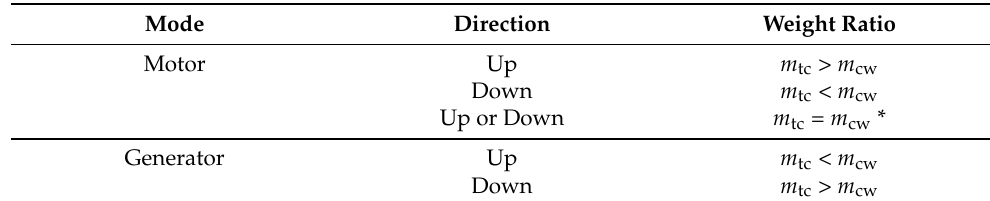
Table 1. Elevator drive operating modes.